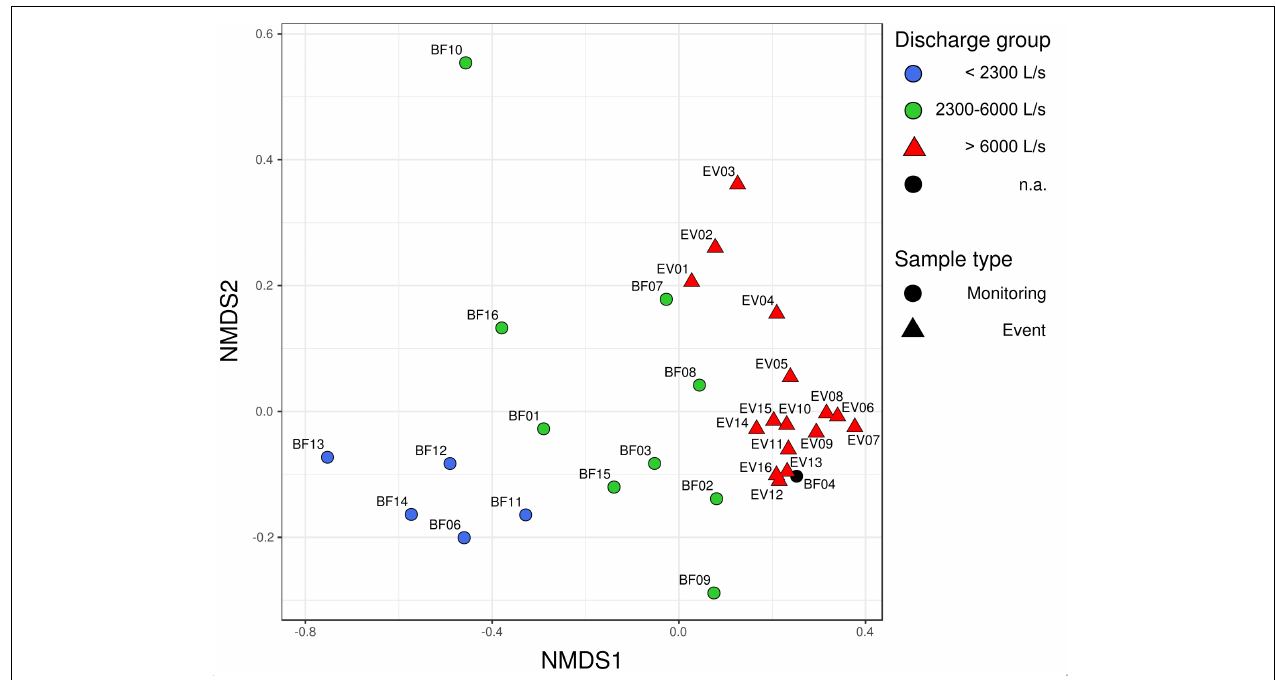
FIGURE 2 | Non-metric multidimensional scaling (NMDS)-plot of community dissimilarities based on the Bray–Curtis dissimilarity index. Stress value of the NMDS was 0.10. Circles depict bacterial communities occurring under baseflow conditions (BF), triangles represent bacterial communities observed under high-discharge event conditions